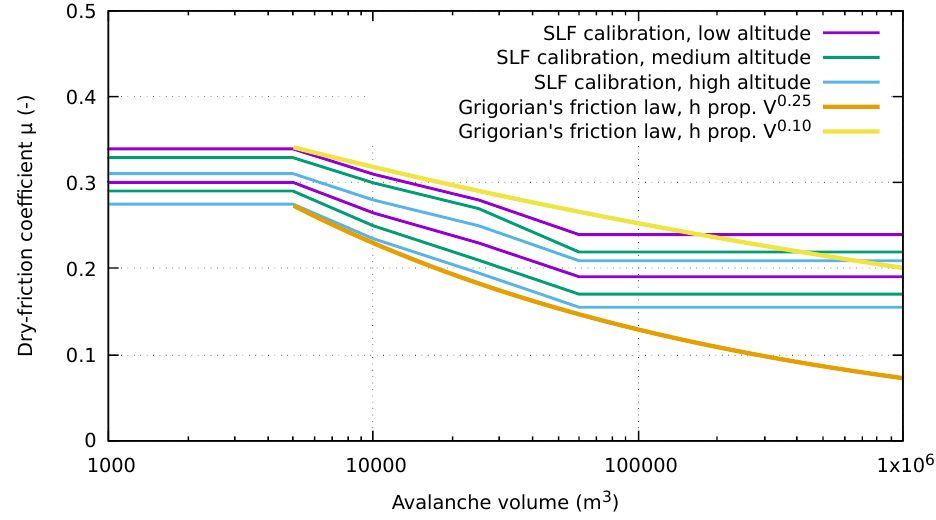
Figure 2. Volume dependence of dry-friction coefficient µ in the recommended calibration for the flow model RAMMS::AVALANCHE for different altitude zones and two types of terrain characteristics. With an assumed scaling relation h ∝ V − 0.25 , the Grigorian’s friction law (GFL) captures that behavior well up to V = 60,000m 3 (brown curve). To avoid large discrepancies for large volumes, the scaling exponent of h needs to be reduced to about 0.1 (yellow